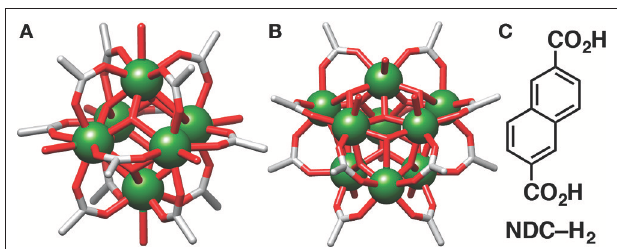
FIGURE 1 | Examples of 12-connected (A) [Y 6 (OH) 8 (RCO 2 ) 12 (H 2 O) 6 ] 2 − and (B) [Y 9 (O) 2 (OH) 14 (RCO 2 ) 12 (H 2 O) 7 ] 3 − SBUs accessible through coordination modulation. (C) Chemical structure of the naphthalene-2,6-dicarboxylic acid (NDC-H 2 )